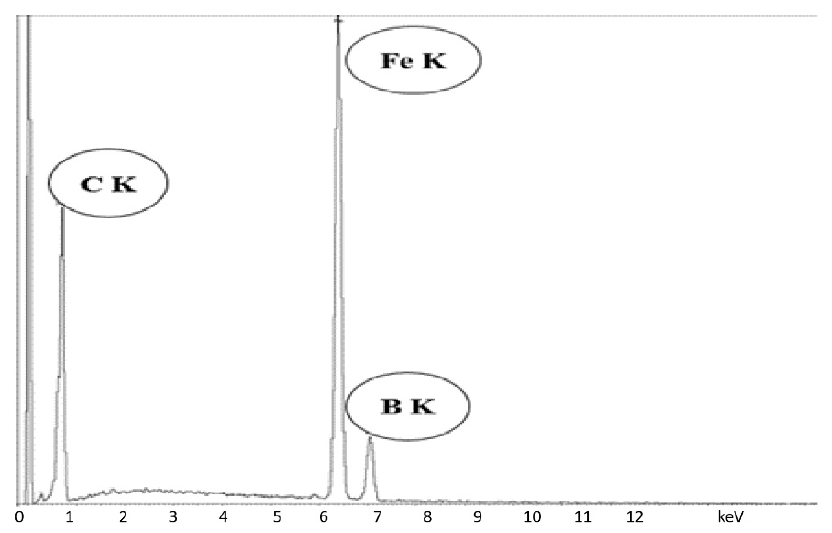
Figure 15. EDX analysis spectrum at point A in specimen welded in inert conditions.